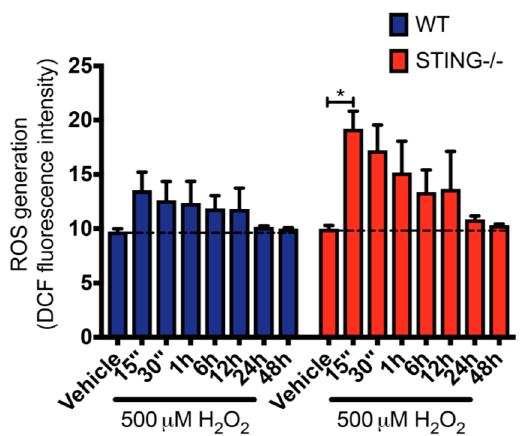
Figure 5. STING − / − cells display greater ROS production in response to H 2 O 2 treatment compared with WT cells. WT and STING − / − cells were treated with 500 µ M H 2 O 2 for the indicated time points before intracellular ROS levels were determine by DCF assay. Data represent mean ± SEM, *p < 0.05, n = 5.